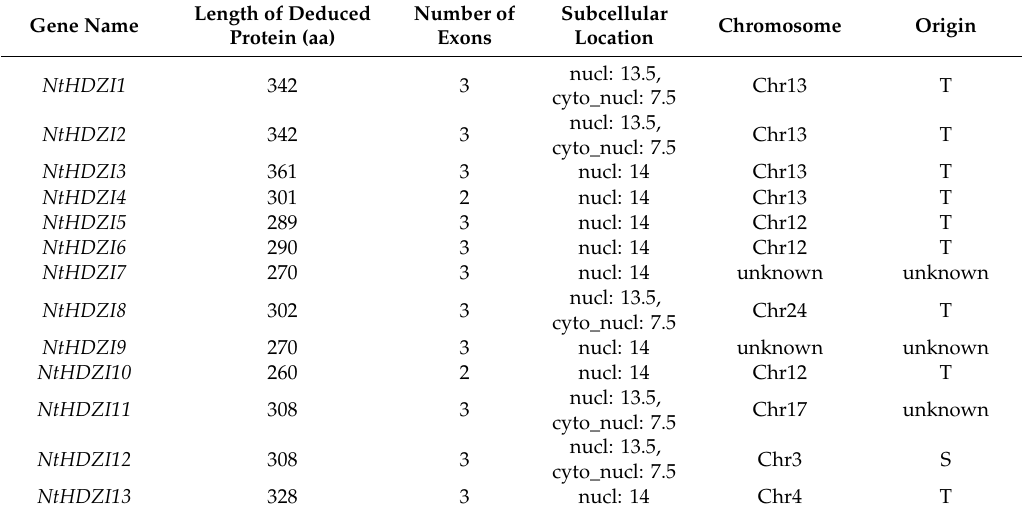
Table 1. Basic characteristics of tobacco homeodomain-leucine zipper ( HD-ZIP) I